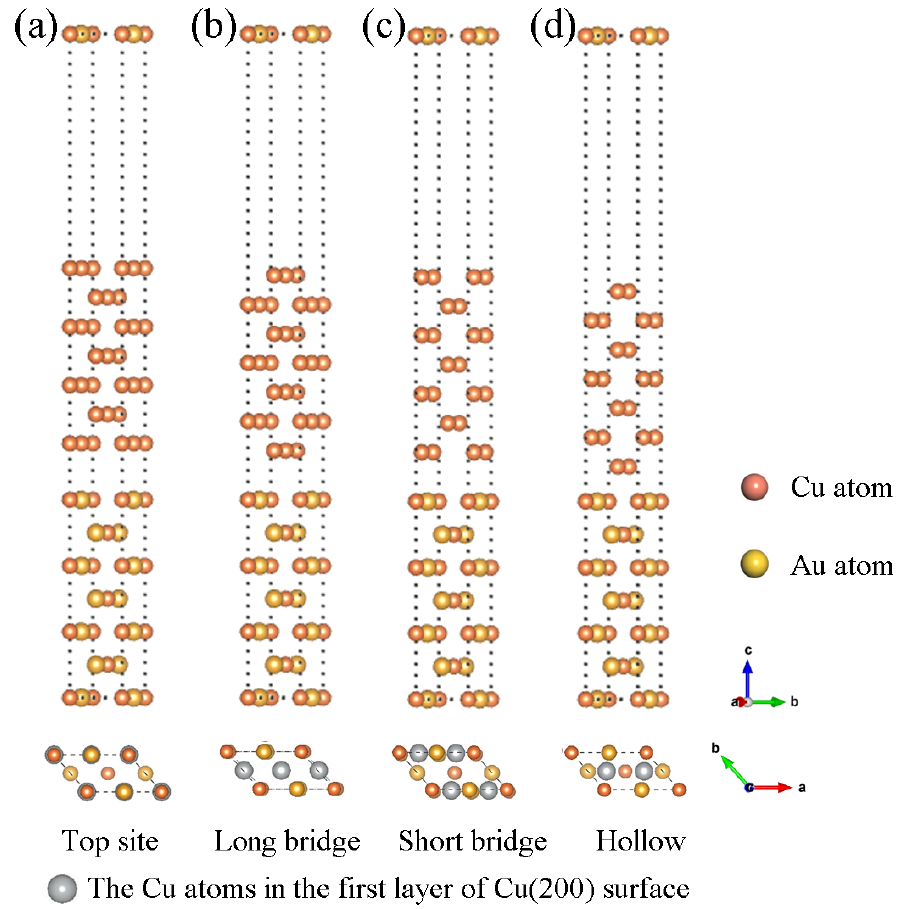
Figure 2. Side view of the four different Cu(200)/AuCu(200) interface model structure (up) and top view of the stack structure to which the interface model belongs (down): ( a ) Top site, ( b ) Long bridge, ( c ) Short bridge, ( d ) Hollow.